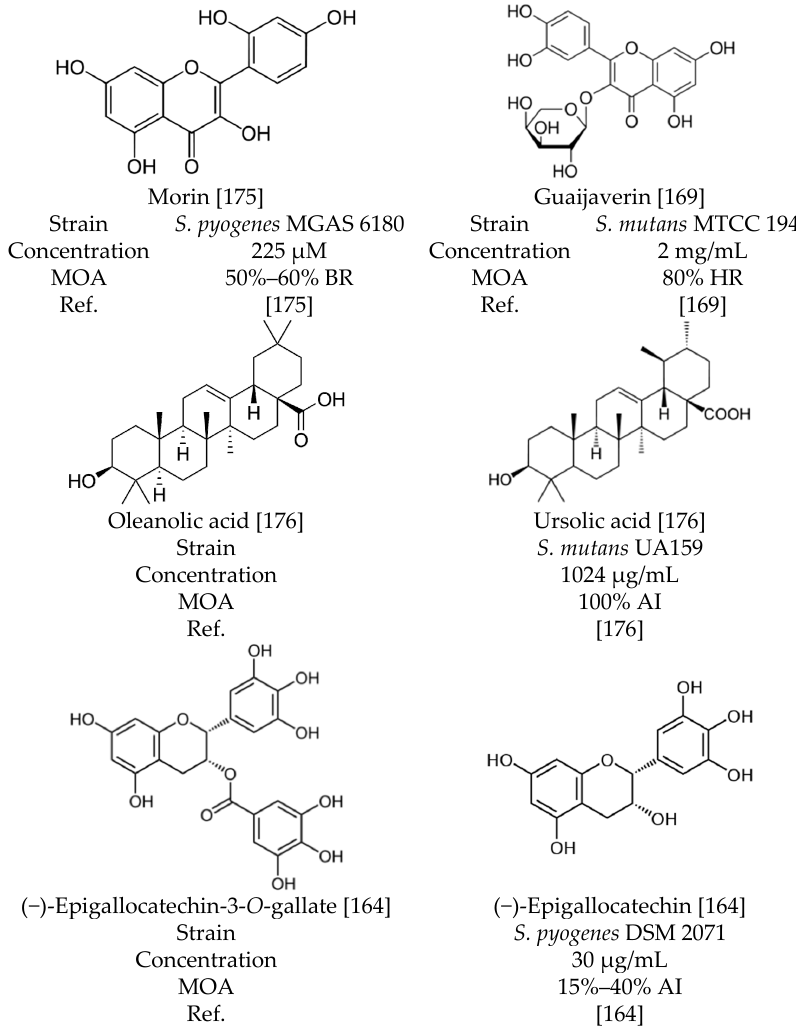
Figure 1. Chemical structure of polyphenols with inhibition activity against adherence, biofilm biomass and hydrophobicity. Abbreviations: AI; Adherence Inhibition, BR; Biofilm Biomass Reduction, HR; Hydrophobicity Reduction, MOA; Mode of Action, Ref.; References